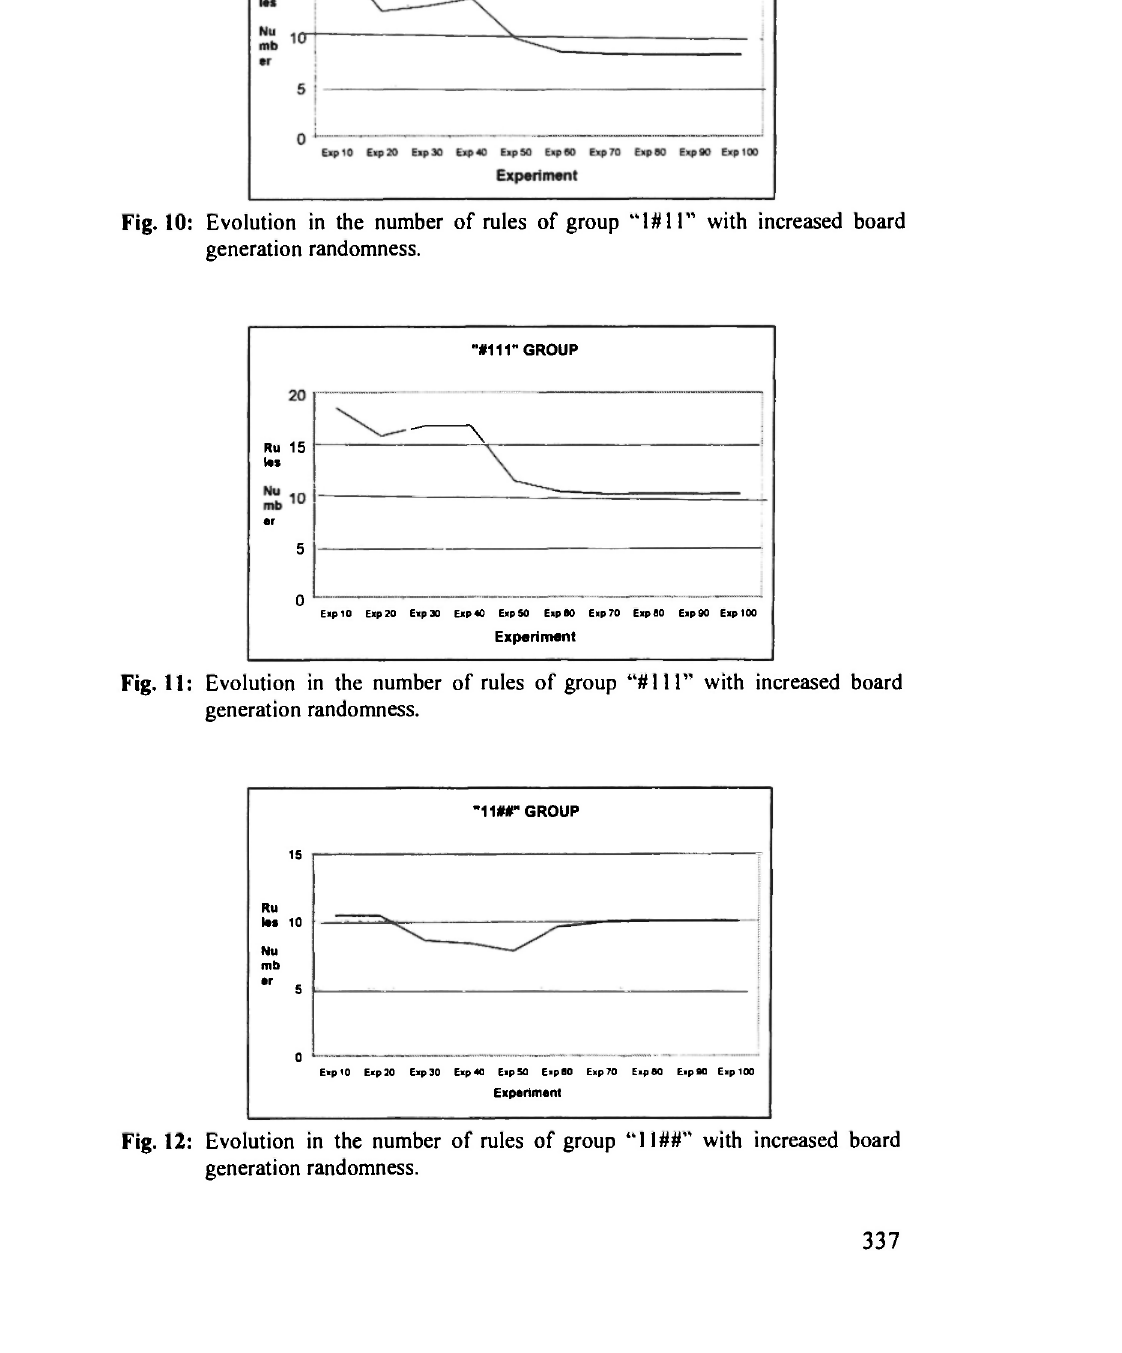
Fig. 10: Evolution in the number of rules of group "1#11" with increased board generation randomness.